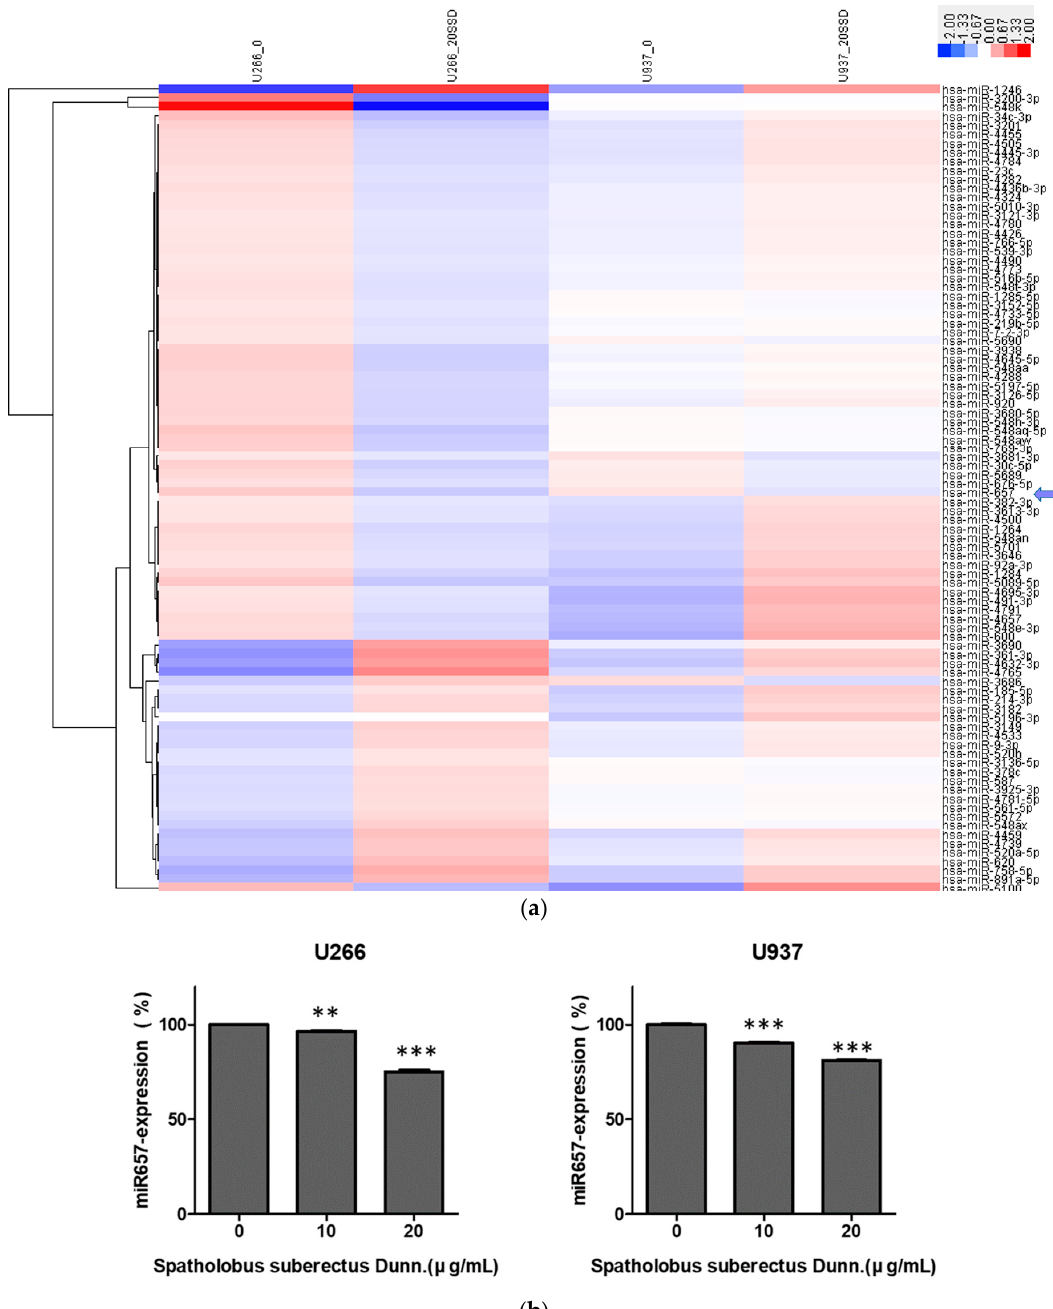
Figure 7. Effect of SSD on microRNA (miRNA) alteration in U266 and U937 cells. ( a ) Heat map clustering of 100 miRNAs involved in ER stress and apoptosis. Red and blue colors represent the magnitude of expression. ( b ) qRT-PCR analyses were conducted for miR-657 with SSD (10 or 20 µg/mL)-treated U266 and U937 cells. Values represent the means of three experiments ± SD; ** p < 0.01; *** p < 0.001 versus the control group.